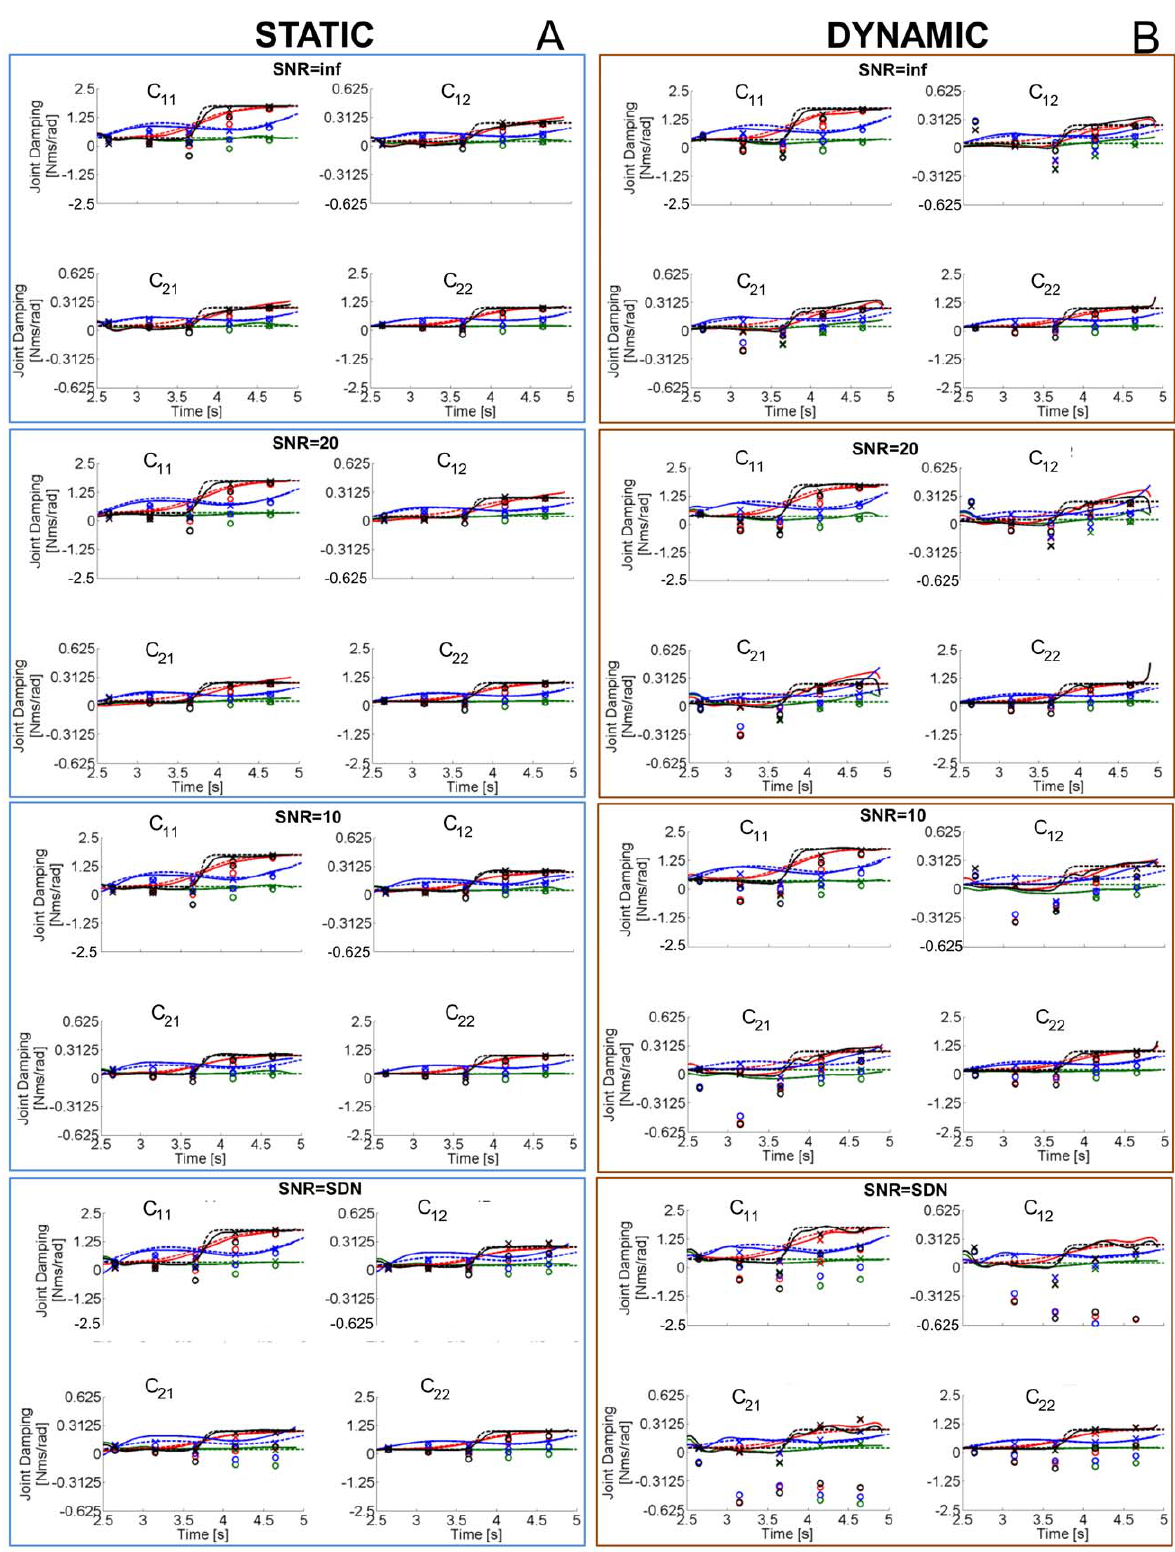
Figure 8. Damping estimations comparisons. Estimations equivalent to those in Figure 7 for the damping parameters, when a ‘‘sigmoidal’’ stiffness profile is imposed. The nomenclature is the same as in Figure 7.